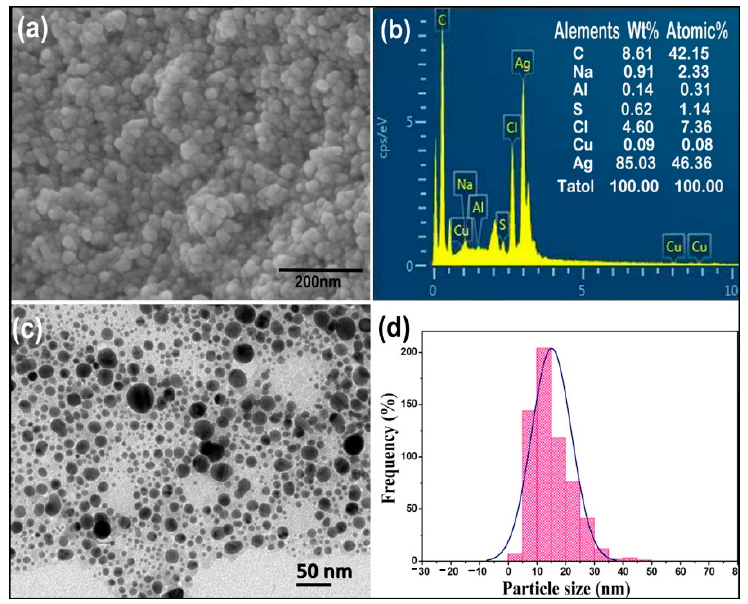
Figure 2. Morphology of silver nanoparticles synthesized using cell-free culture supernatant (CFCS) of strain IMA13: ( a ) SEM; ( b ) EDS; ( c ) TEM; ( d ) distribution frequency (%) of AgCl-NPs particle